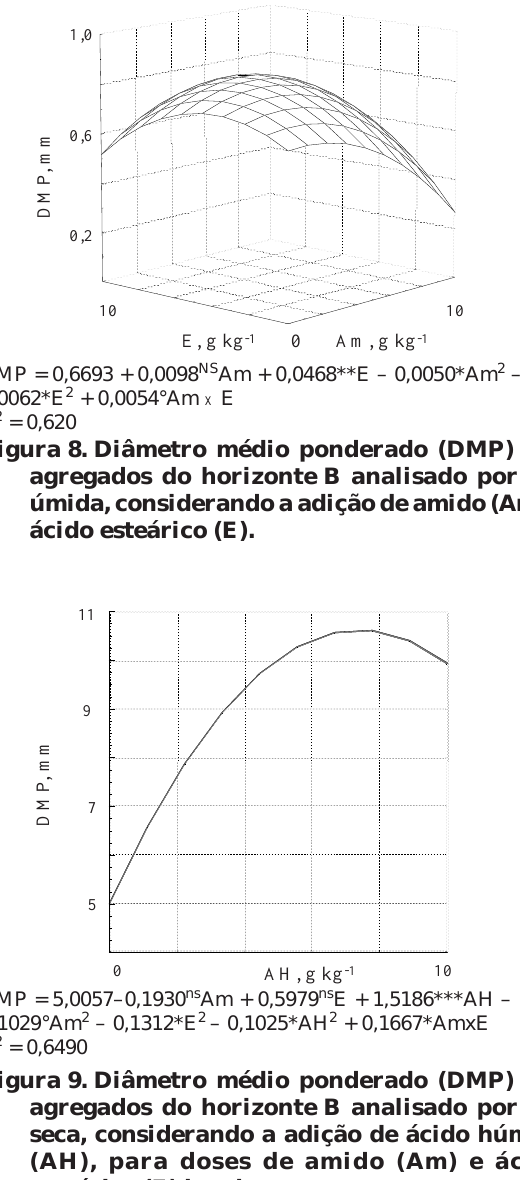
R. Bras. Ci. Solo, 29:11-20, 2005